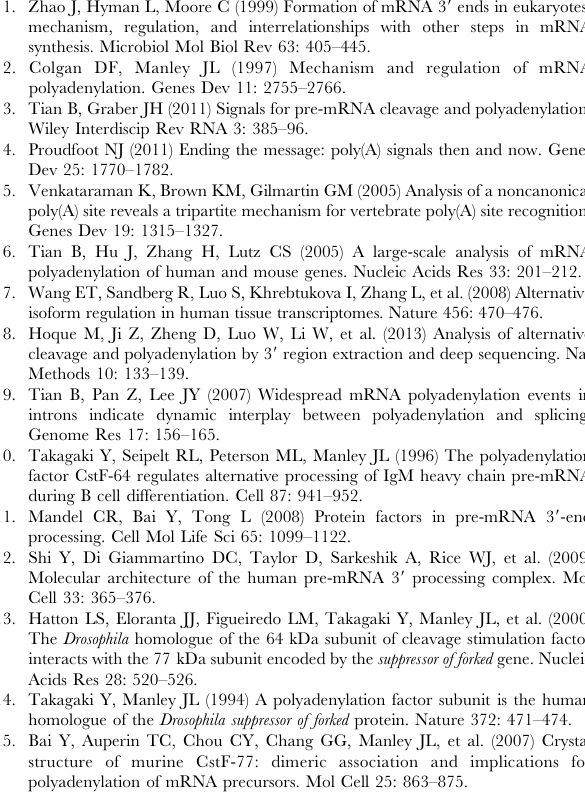
Figure S10 Pentamers enriched for pAs of downregulated (top) or upregulated genes (bottom). Only genes with a single pA were used for analysis. (PDF) Figure S11 Gene expression changes vs. 3 9 UTR regulation after CstF-77 knockdown. ( A ) All genes. ( B ) Cell cycle genes. For each gene set, genes were divided into 3 groups based on 3 9 UTR regulation. P-values (Wilcoxon test) comparing two sets are shown. Table S1 Constructs used for reporter assays. Table S2 siRNAs used in this study. All siRNAs are for mouse genes unless indicated otherwise. Table S3 Antibodies used in this study. Table S4 RT-qPCR primers used in this